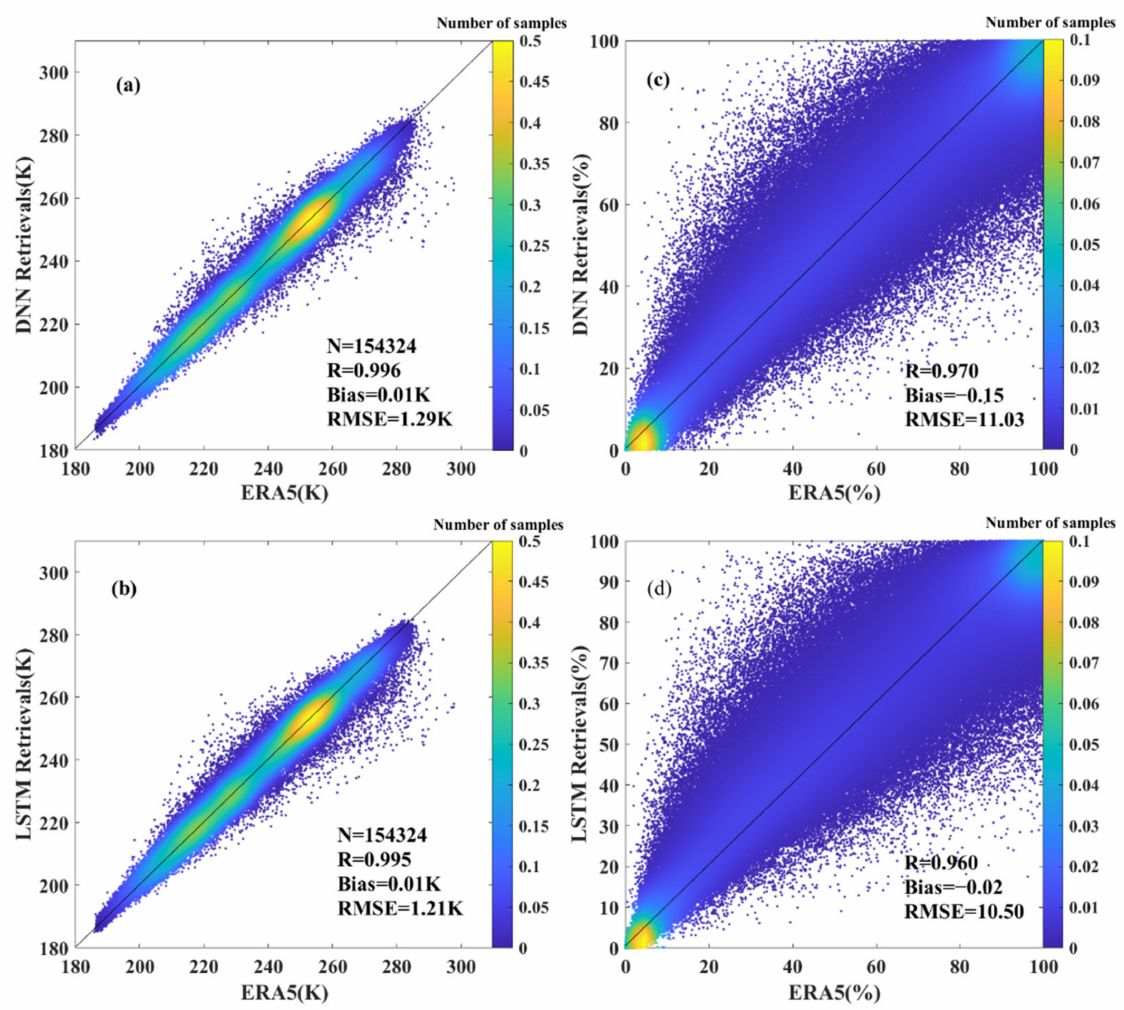
Figure 5. The retrieval results of the DNN and LSTM models versus the ERA5 over sea ice using the validation dataset in June 2021. ( a , b ) are the atmospheric temperature retrieval results of the DNN model and LSTM model, respectively. ( c , d ) are the atmospheric humidity retrieval results of the DNN model and LSTM model,